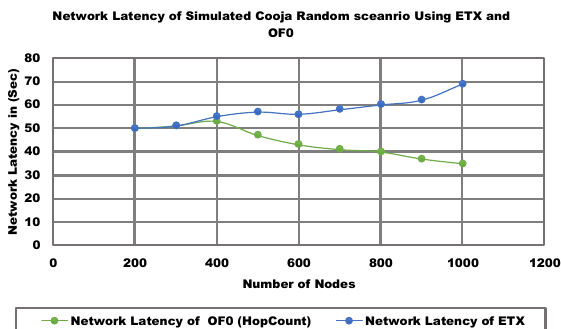
Figure 17. Latency comparison using OF0 and ETX with random Cooja simulator.